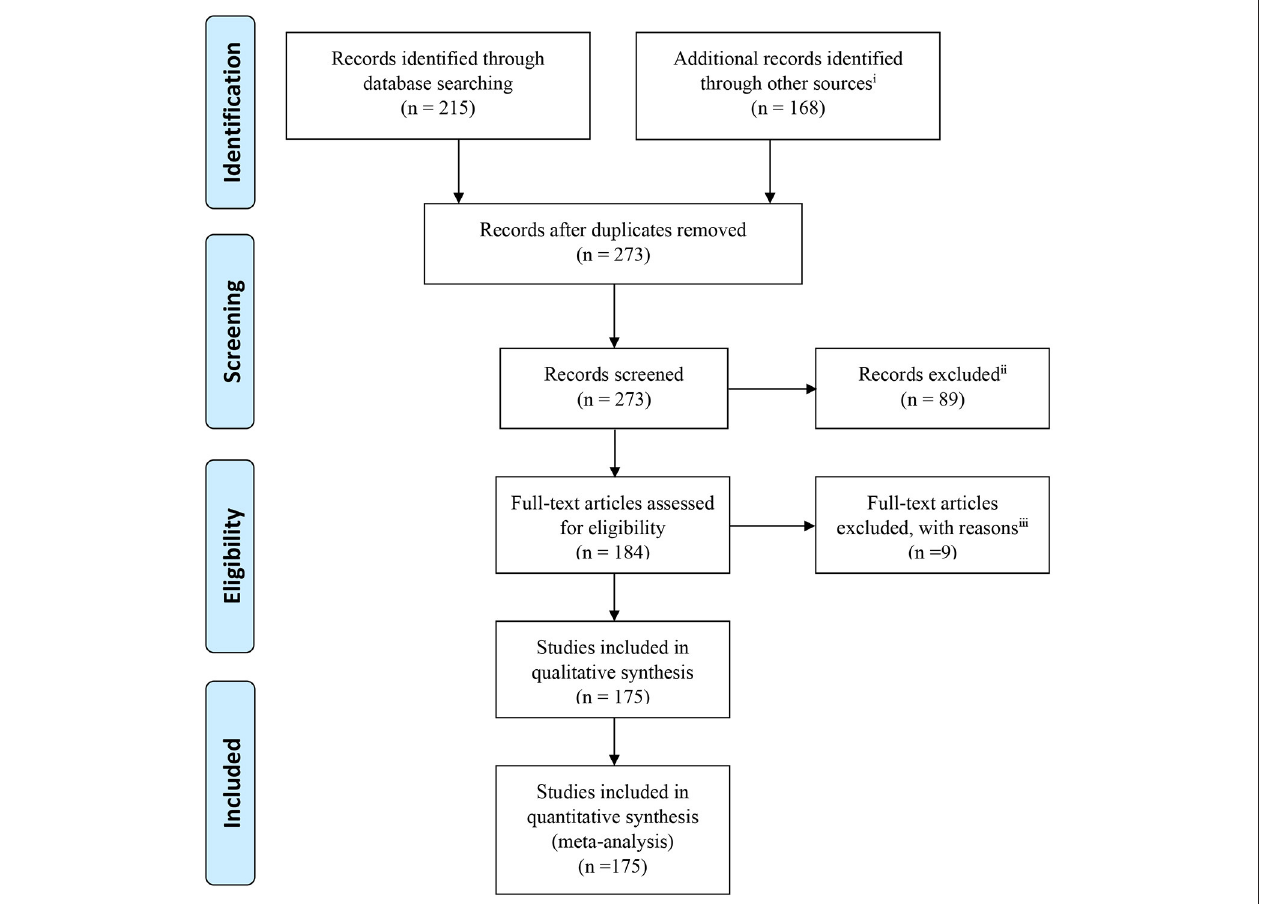
FIGURE 1 | PRISMA flowchart showing the classification of the extracted articles related to the epileptic focus localization through simultaneous EEG–fMRI recording. i Web of Science, Google Scholar, Pub Med, Scopus dataset, and ResearchGate websites and the references of the research and review articles. ii Not relevant to research question, aims and objectives, or old articles. iii Intracranial or ictal